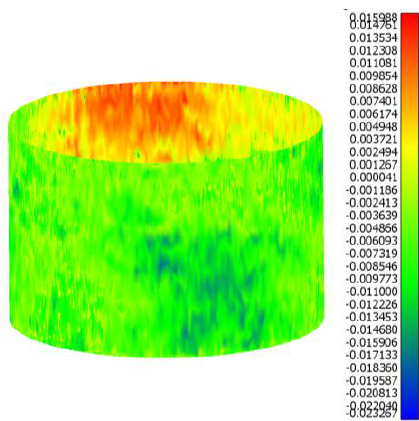
Figure 5. Comparison of two SMSs with an unequal number of points, colored based on the Hausdorff distance values.